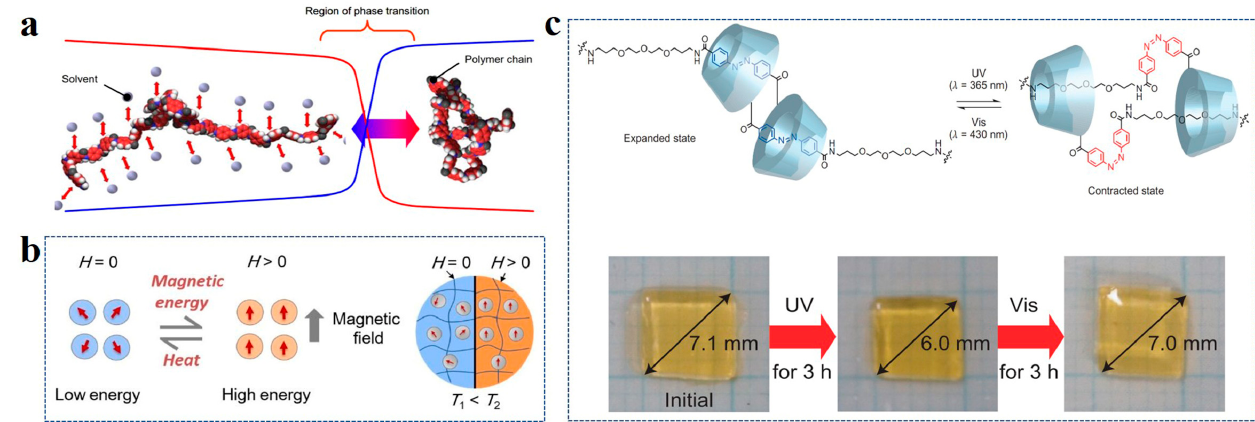
Figure 5. ( a ) Phase transition of polymer chain during swelling. Reprinted with permission from Reference [75]. ( b ) Magnetothermal phenomena of hydrogels doped with magnetic particles. Reprinted with permission from Reference [78]. ( c ) Hydrogel volume changes by azo-based light response. Reprinted with permission from Reference [81].